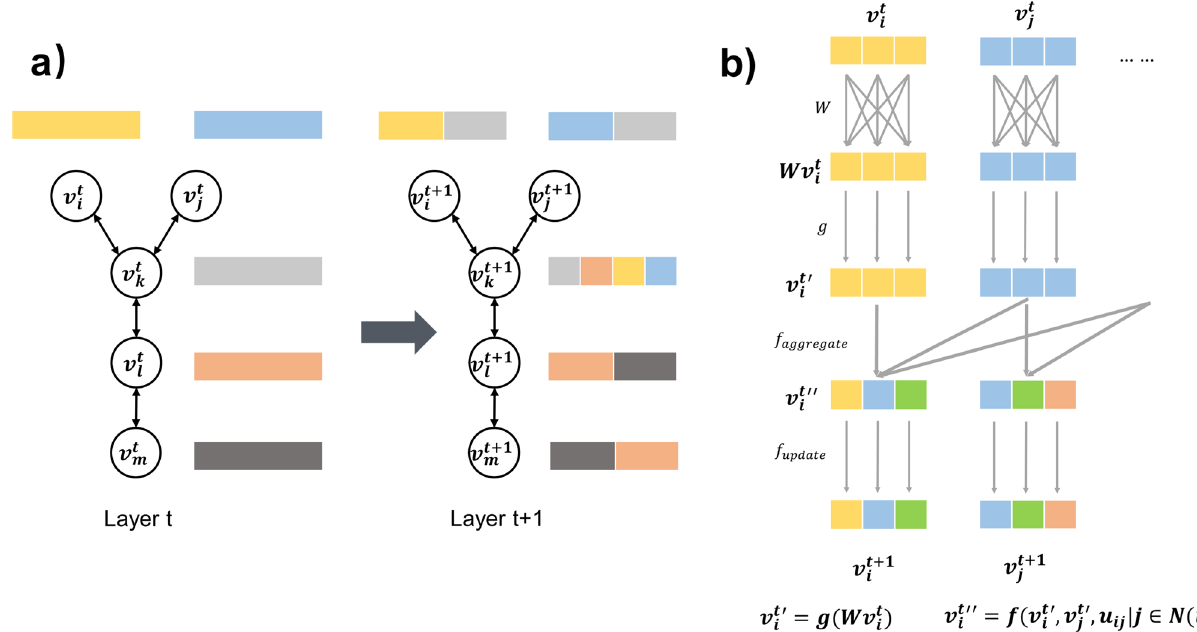
Fig. 8 A demonstration of the node aggregation and updating in GNN. a The full picture of one step of forward propagation in GNN. b The detailed process in two nodes. v t means the i th node in the t th layer, u t means the edge between node i and j in the t th layer (in this work, u t i ij is a learnable parameter matrix, f and g are nonlinear functions.